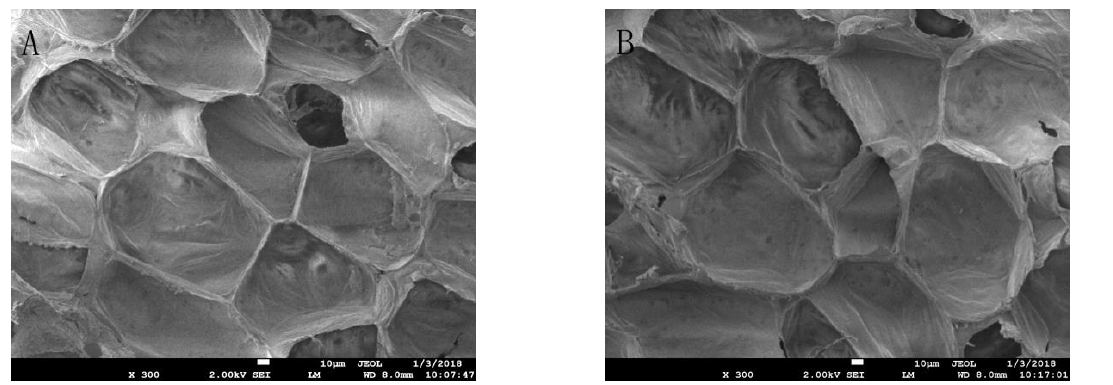
Figure 6. Scanning electron microscopy (SEM) images of cucumber pulp. ( A ). Control cucumber pulp cells; ( B ). Treated cucumber pulp cells.